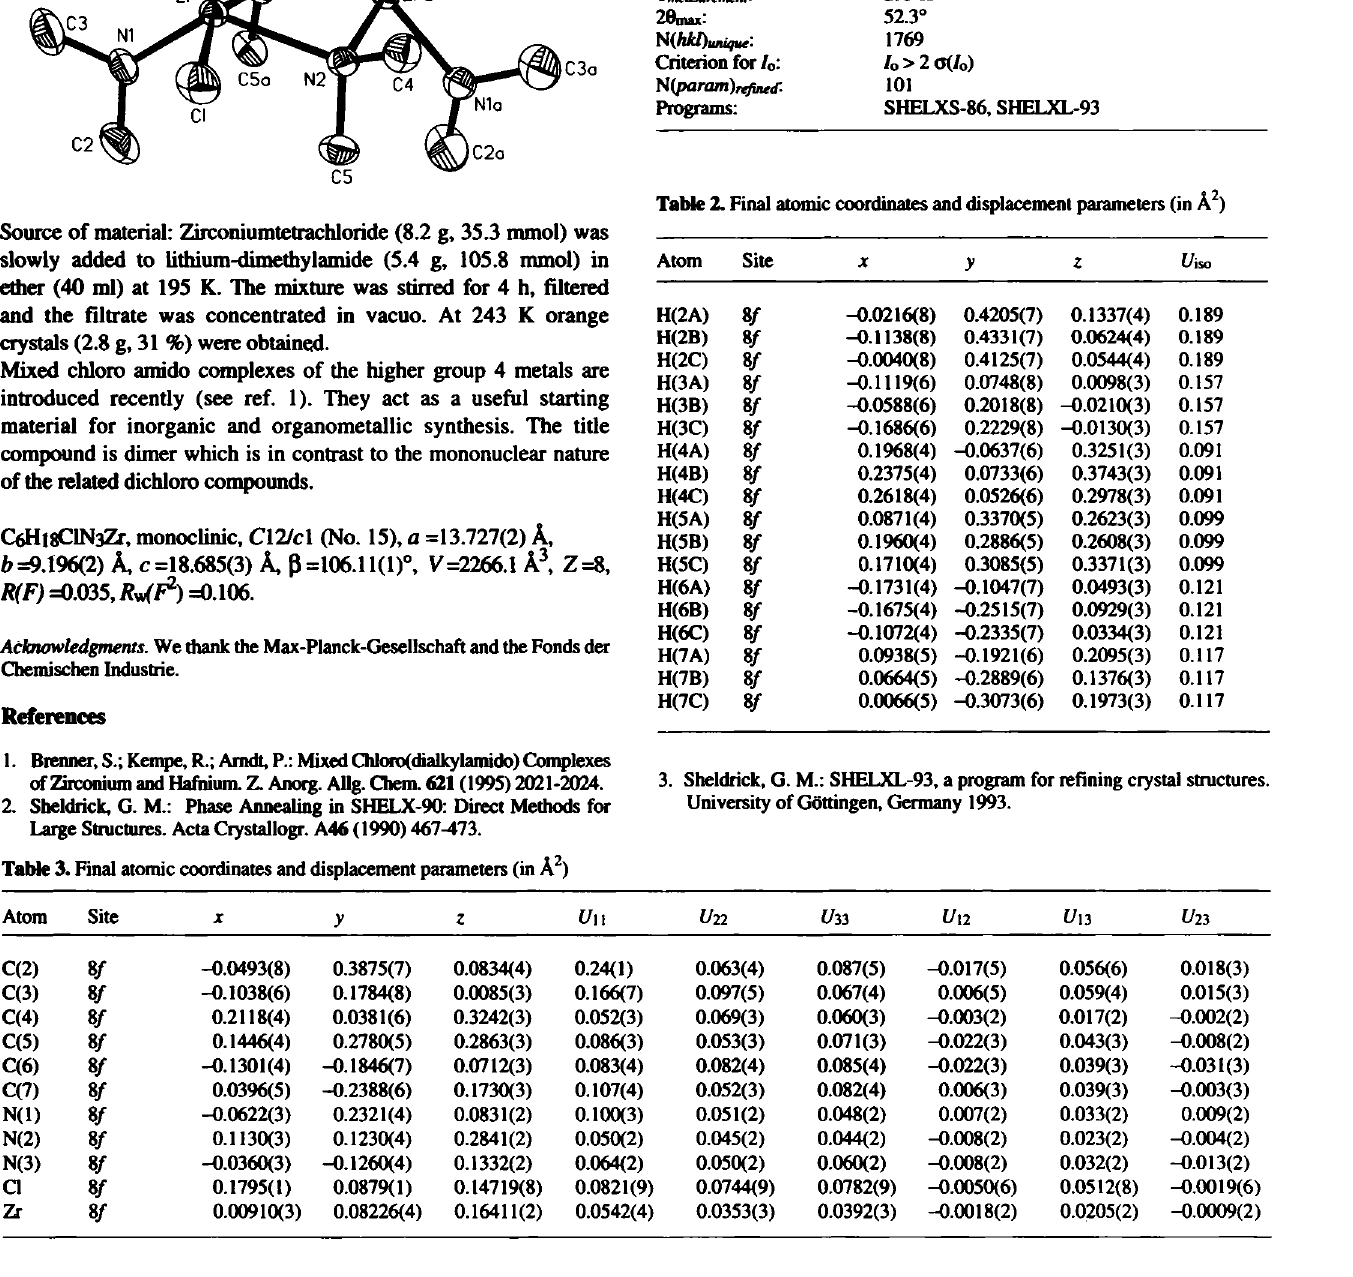
Table 1. Parameters used for the X-ray data collection